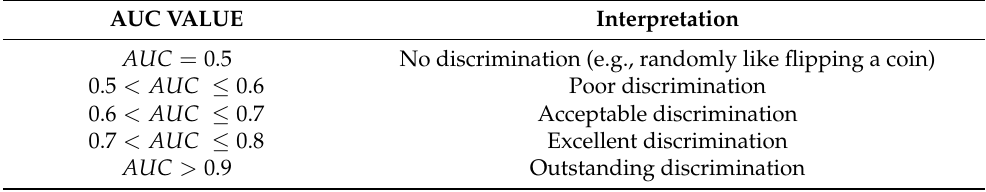
Table 3. Interpretation of